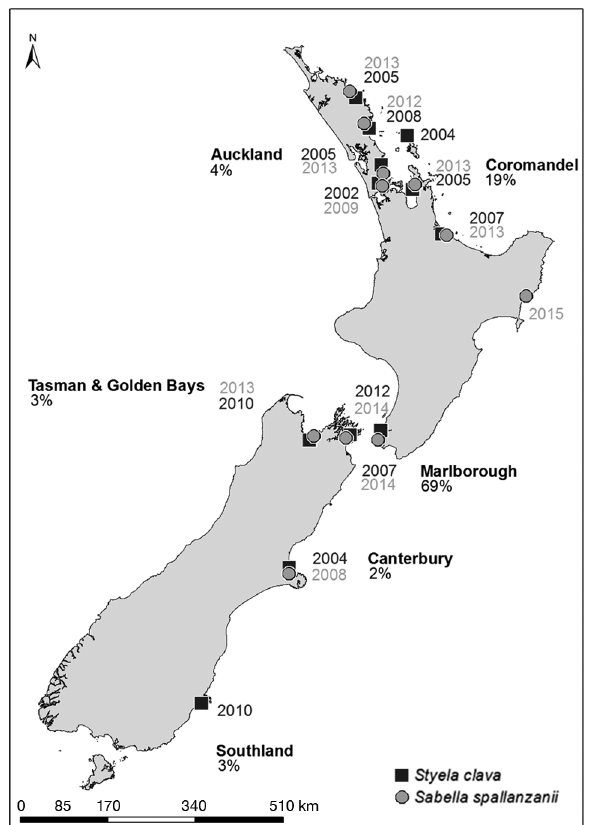
Fig. 1. Distribution of green-lipped mussel growing areas (regions with percentage of total production) and the years at which Styela clava and Sabella spallanzanii were de- tected in nearby ports